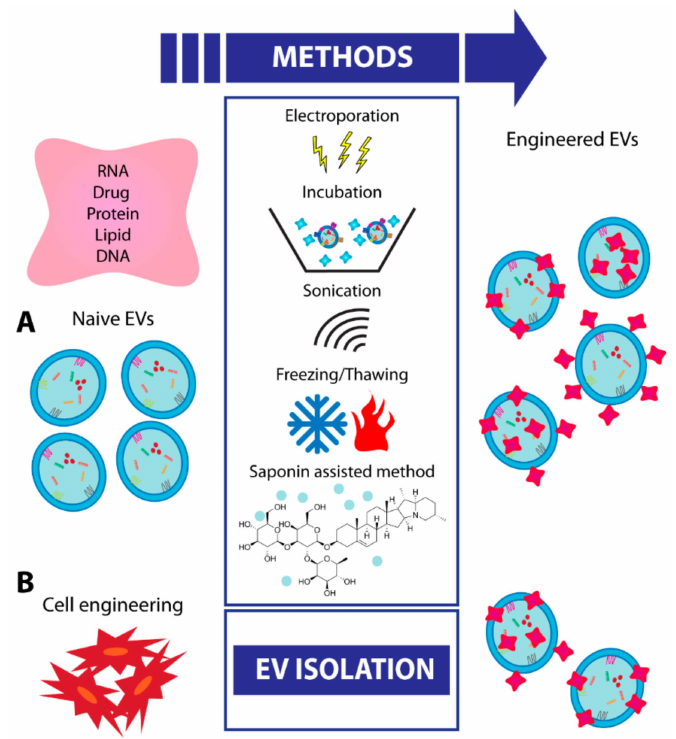
Figure 2. Schematic representation of di ff erent procedures for EV engineering. ( A ) Schematic representation of techniques for engineering EVs after their isolation (direct method). ( B ) Schematic representation of cell engineering followed by EV isolation (indirect